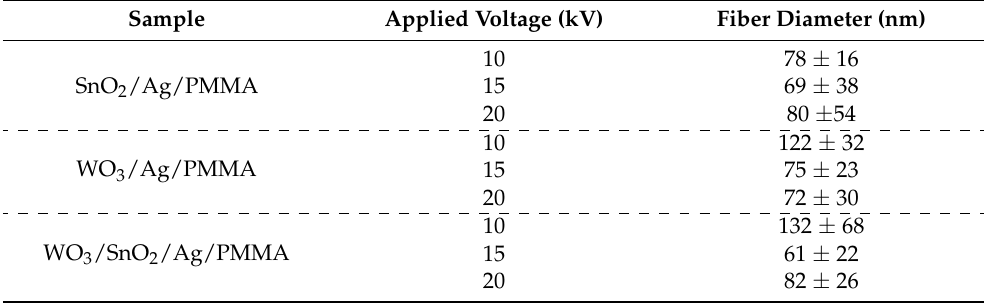
Figure 2. SEM images and boxplot of fiber diameter distribution of electrospun fibers: ( a – d ) SnO 2 /Ag/PMMA, ( e – h ) WO 3 /Ag/PMMA, and ( i – l ) WO 3 /SnO 2 /Ag/PMMA. Electric field: ( a , e , i ) 10 kV, ( b , f , j ) 15 kV, and ( i , j , k ) 20 kV. The boxplots show medians, interquartile ranges and outliers. Table 1. Average diameter of SnO 2 /Ag/PMMA, WO 3 /Ag/PMMA and WO 3 /SnO 2 /Ag/PMMA fibers with various applied